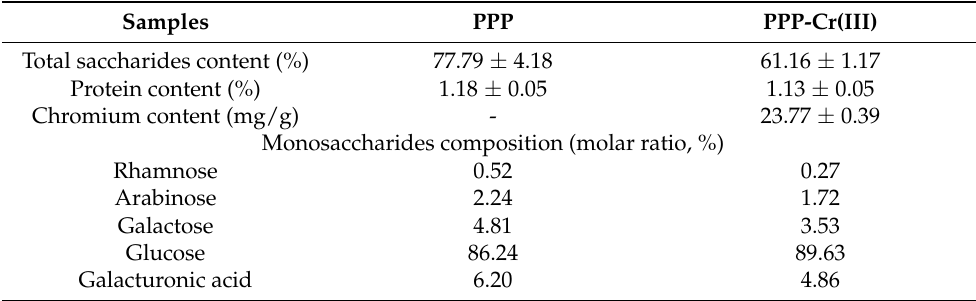
Table 1. Chemical composition and monosaccharide composition of PPP and PPP-Cr(III). Samples PPP PPP-Cr(III) Total saccharides content (%) 77.79 ± 4.18 61.16 ± 1.17 Protein content (%) 1.18 ± 0.05 1.13 ± 0.05 Chromium content (mg/g) - 23.77 ± 0.39 Monosaccharides composition (molar ratio, %) Rhamnose